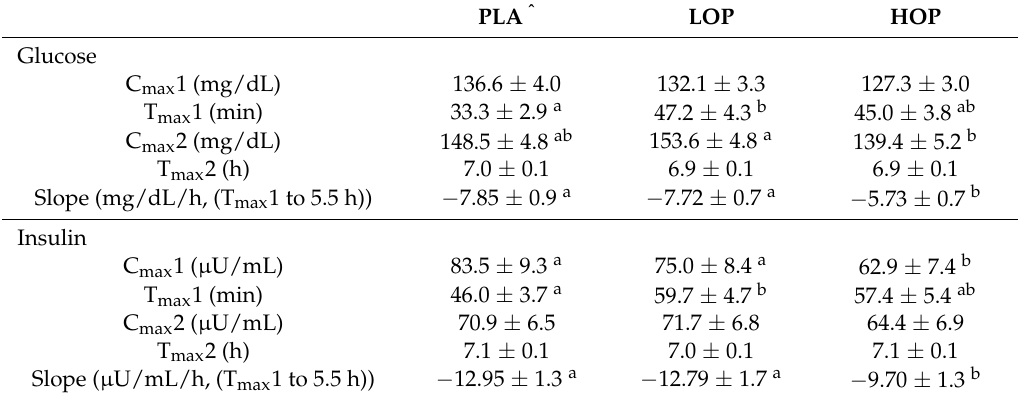
* Values are expressed as mean ± SEM; ^ Abbreviations: PLA, placebo; LOP, low dose orange pomace beverage, HOP, high dose orange pomace beverage; a,b Means without sharing the same letter within the same row differ, tested by the general linear mixed effects model, followed by Tukey HSD multi-comparison test, p ≤ 0.05.